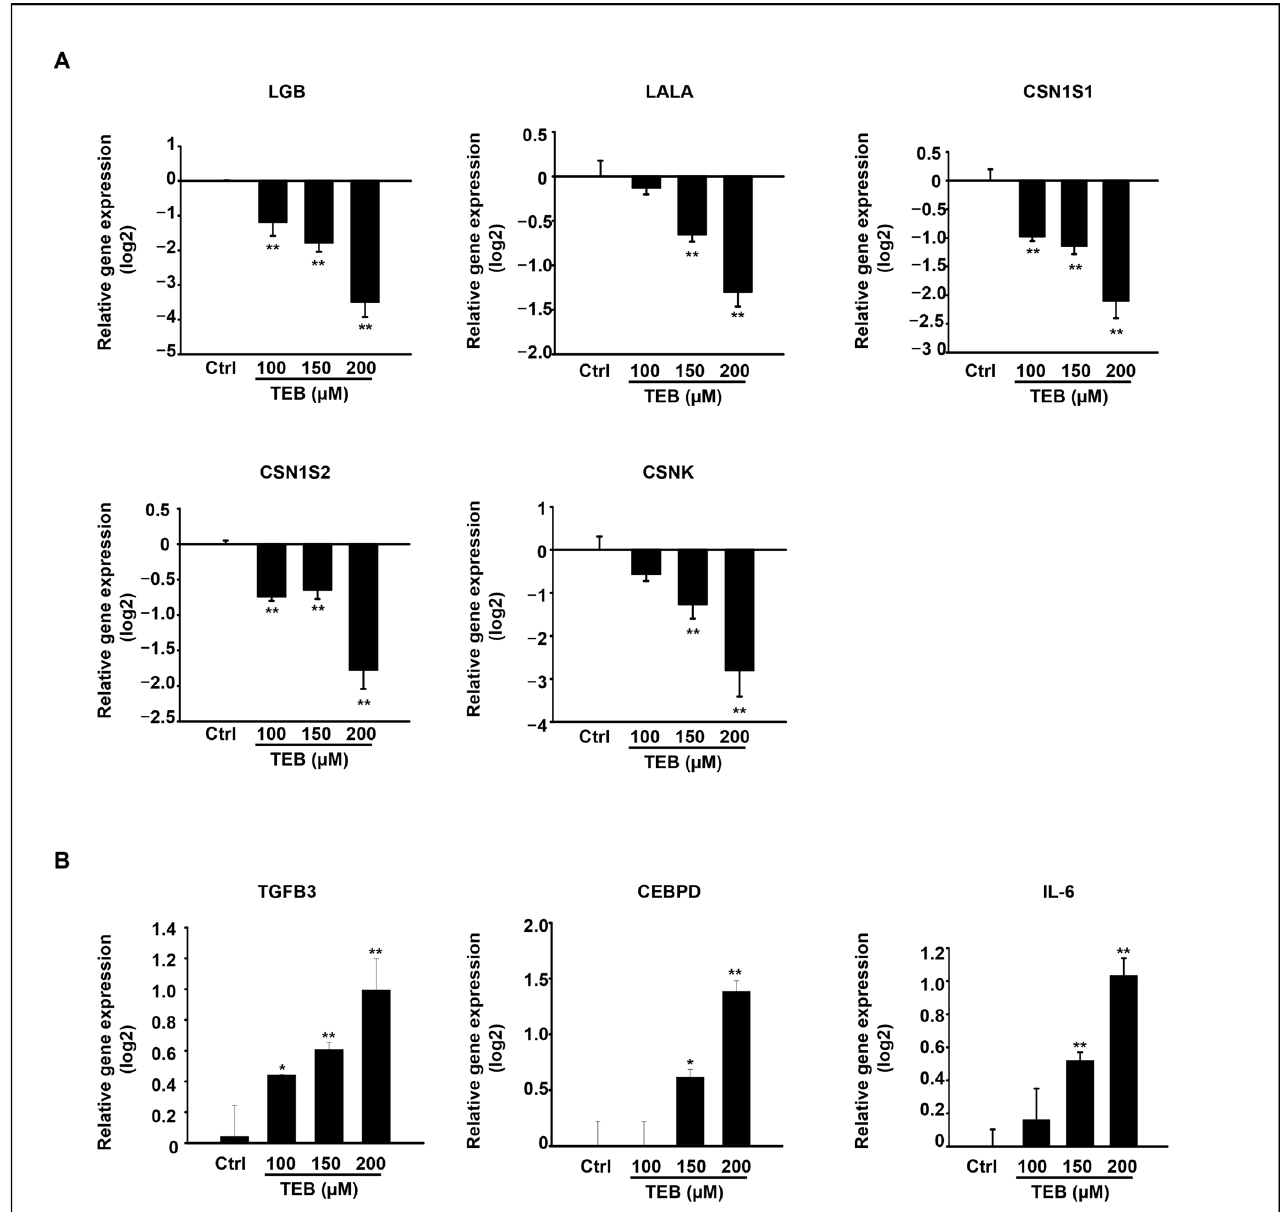
Figure 5. The expression of milk-protein-synthesis-related genes in TEB-treated MAC-T cells. ( A ) mRNA expression levels of LGB, LALA, CSN1S1, CSN1S2, and CSNK, and ( B ) the gene expression levels of inflammatory genes TGFB3, CEBPD, and IL -6 in TEB-exposed MAC-T cells by qPCR. The graph represents the mean ± SD of three independent experiments (n = 4 * p < 0.05, and ** p < 0.001 compared to the controls).